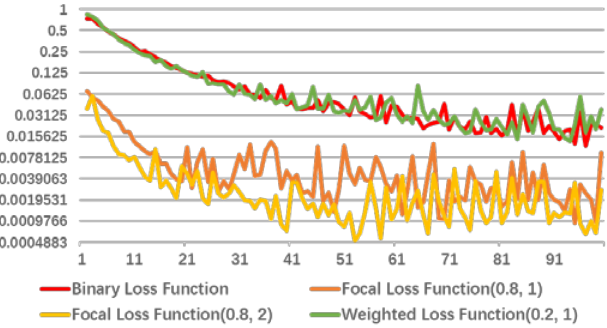
Figure 8. Loss convergence of binary cross-entropy loss function, focal loss (0.8, 1), focal loss (0.9, 2) and weighted loss (0.2, 1) in the first 100 steps.